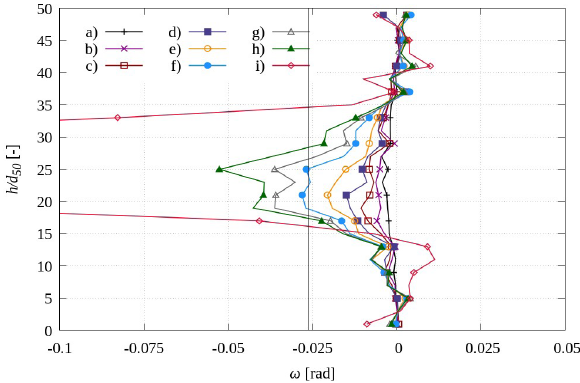
across x at the specimen centre for: a) 50 = 0.50 mm, c) u = 0.75 mm, d) u = 1.00 mm, e) x x x = 1.50 mm, g) u = 1.75 mm, h) u = 2.00 mm and i) x x x = 0.60, σ = 200 kPa, d = 0.5 mm) (dark vertical 0 0 50